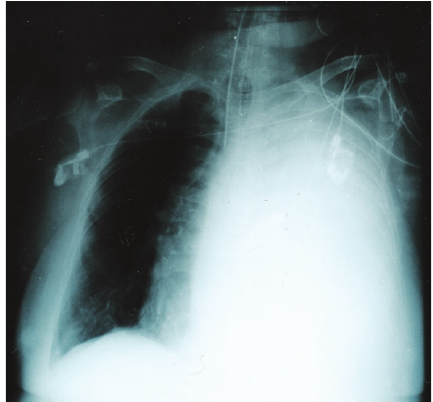
Figure 1: The admission chest X-ray showing complete opacifica- tion of the left hemithorax and displacement of the mediastinum to the right.